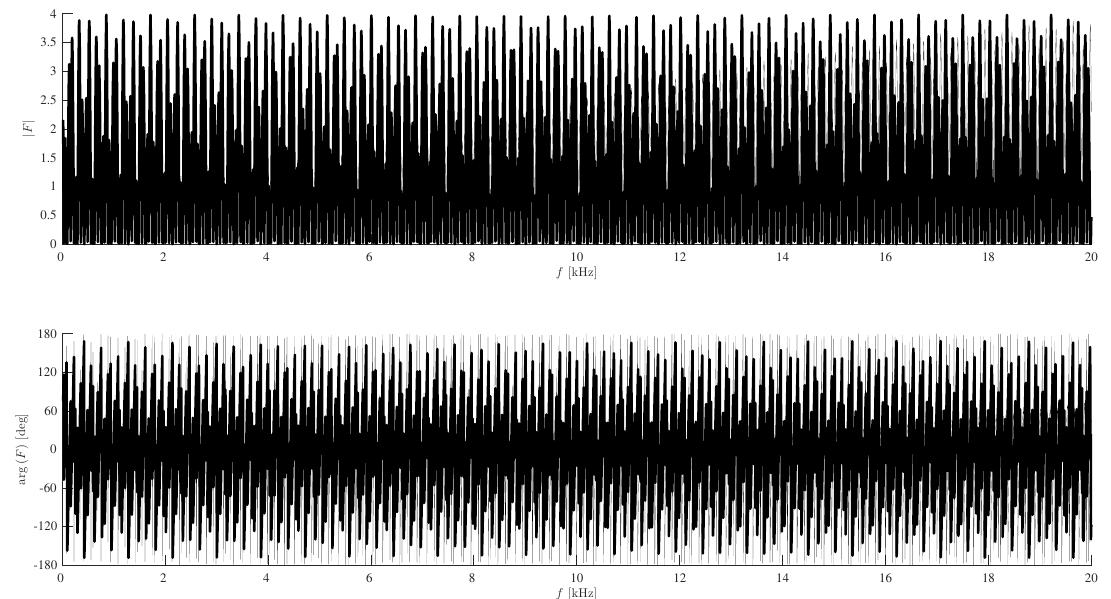
Figure A4: The same as Figure A3 for low source direction, β = 30 °, below the